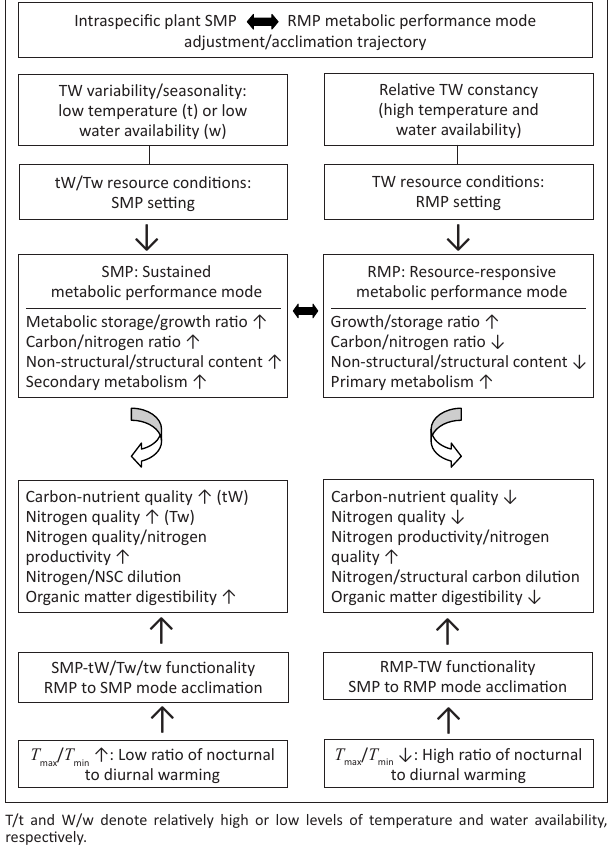
FIGURE 5: Sustained metabolic plant performance (SMP) to resource-responsive metabolic performance (RMP) mode adjustments to resource conditions, also representing the SMP to RMP temperature acclimation trajectory endpoints (climate–vegetation response process